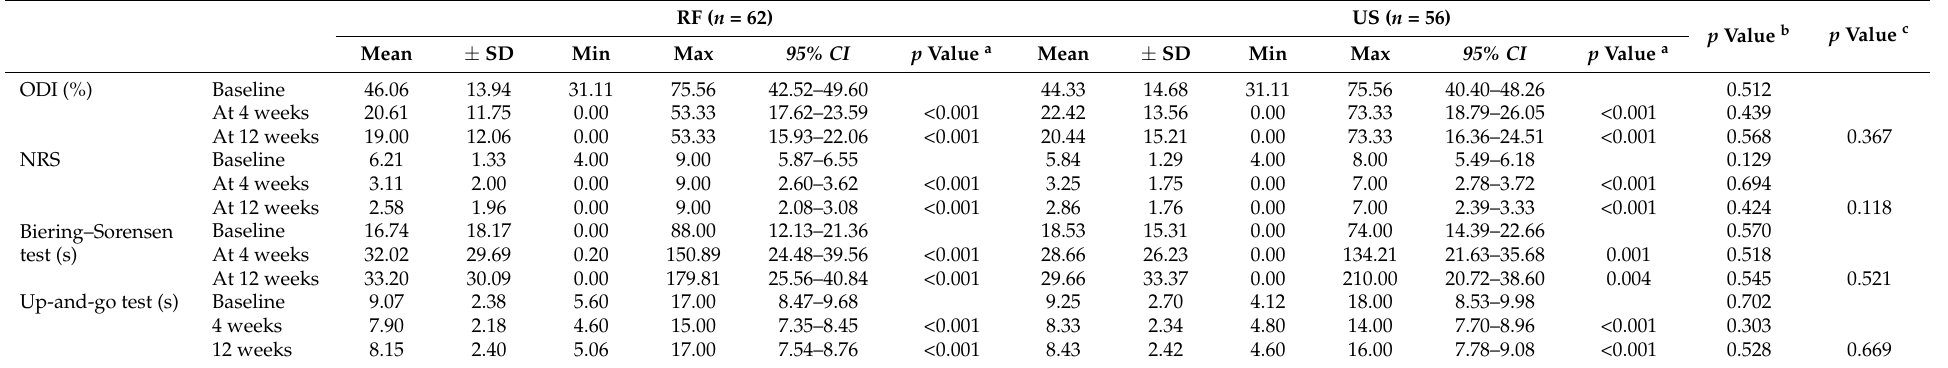
Table 3. Changes in clinical and functional parameters in both